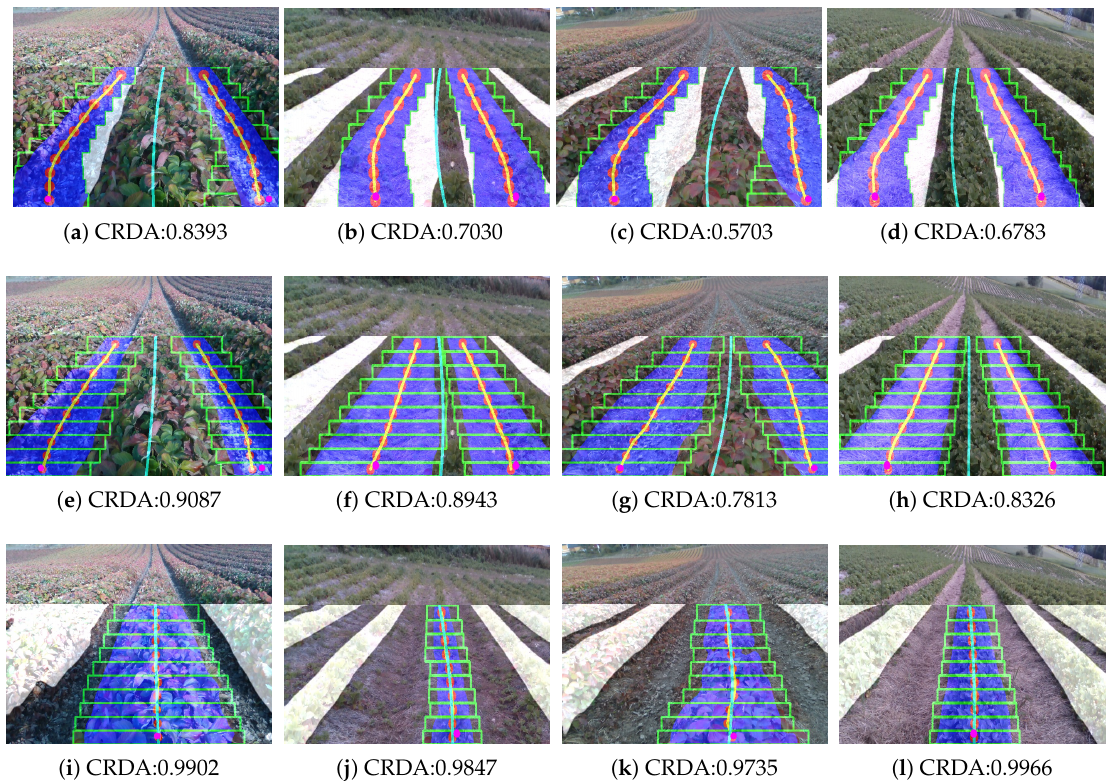
Figure 12. Fitting results for four test cases depicting the variance of strawberry crop rows. Columns represent Multi-ROI fitting results using fixed-size ROIs (green) ( a – d ). The proposed Adaptive Multi-ROI fitting results using adaptive-size ROIs (green) are showcased for lanes ( e – h ), and crops label ( i – l ). The Adaptive Multi-ROI can find the cluster centers (red) in the lane or crop regions. A regression fitting applied over the average of fitted labels (yellow) and obtained the centerline (cyan) for the robot to follow the crop row. The metric CRDA tells how well the centerline for autonomous guidance is estimated against the ground truth.